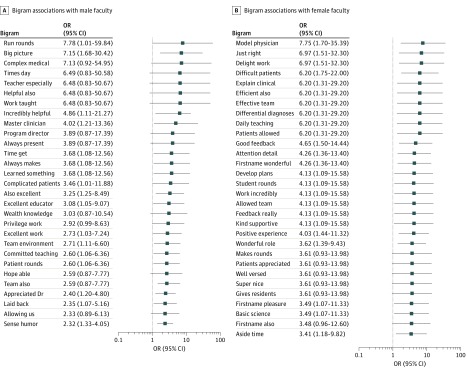
Significant 2-Word (Bigram) Associations by Faculty GenderOR indicates odds ratio.